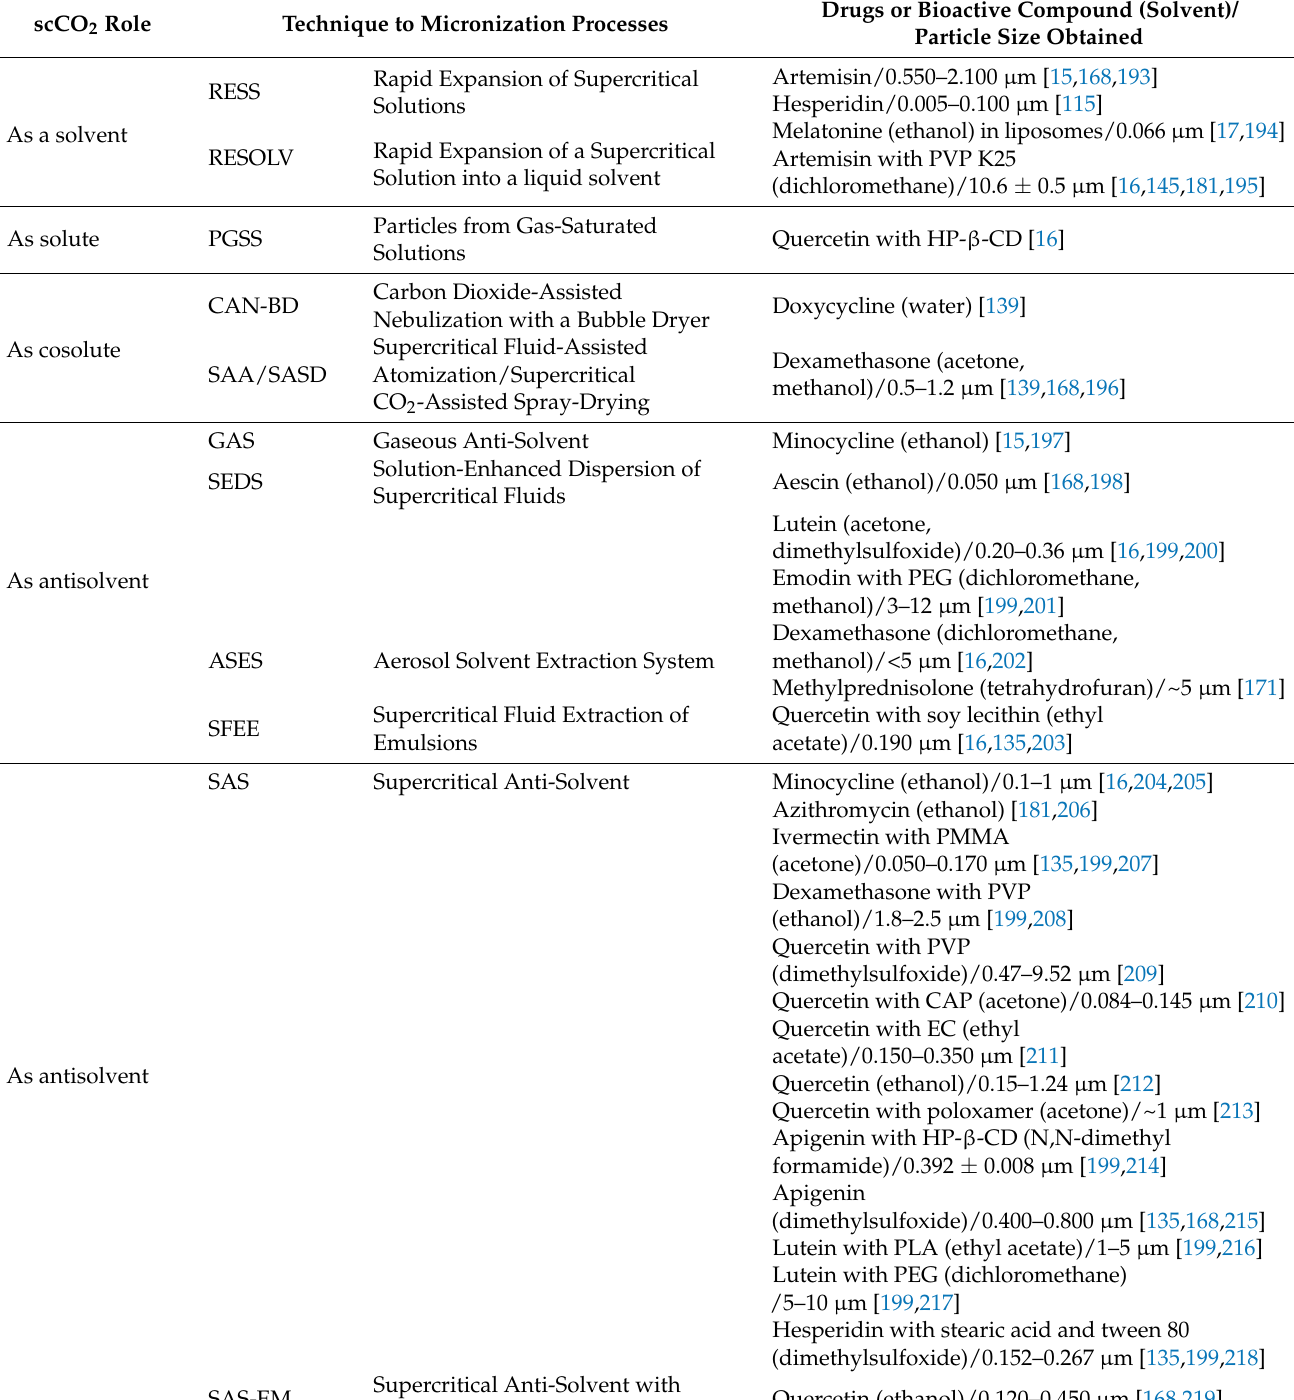
Table 3. Micronization techniques according to supercritical CO 2 role, applied in drugs or bioactive compounds tested against